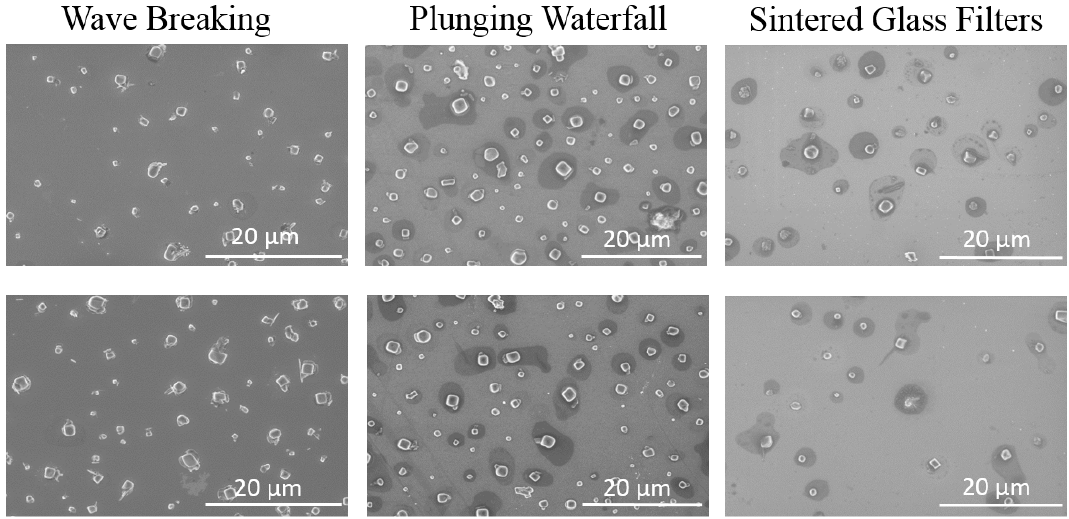
Figure 6. SEM images of particles generated by each of the three laboratory SSA generation mechanisms considered in this study (two images shown for each case). All samples are dried in the vacuum of the SEM during the analysis process. The increased circularity of the particle cores is visible when comparing the sintered glass filter SSA samples to the plunging-waterfall and wave-breaking